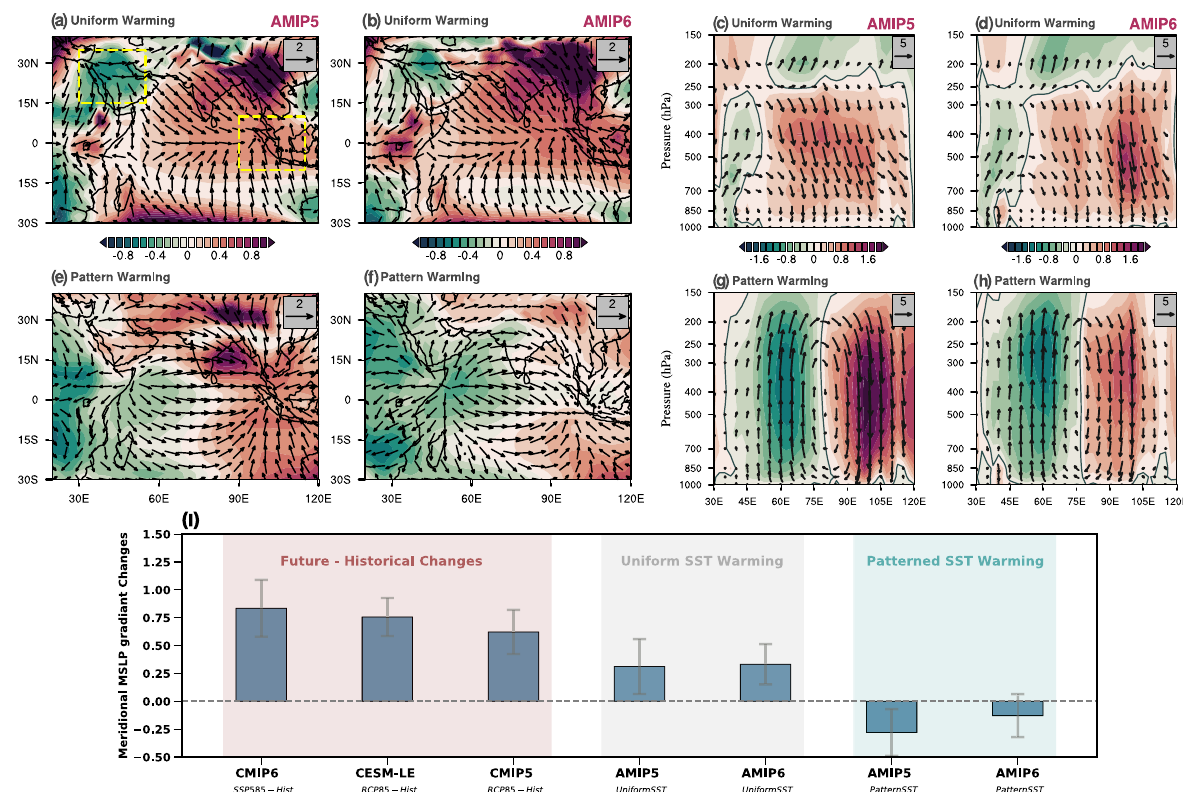
Fig. 4 Circulation changes in the uniform and patterned SST warming atmospheric-only model experiment. Ensemble mean changes in MSLP (hPa, shaded) and the divergent wind at 200 hPa (m/s, vectors) in a AMIP5 uniform SST warming (AMIP4K minus AMIP) and b AMIP6 uniform SST warming (AMIPP4K minus AMIP) simulations forced by prescribed SST change. e , f Same as in ( a , b ) but for AMIP5 patterned SST warming (AMIPFuture minus AMIP4K) and AMIP6 patterned SST warming (AMIPFuture4K minus AMIPP4K). The yellow boxes in fi gure a i.e., (90°E – 115°E, 10°S – 10°N) and (30°E – 55°E, 15°N – 35°N) are used to calculate the meridional MSLP gradient which represents the manifestation of the LHC on the surface (see “ Methods “ for more details). The longitude-height cross-section of ensemble mean changes in vertical velocity (Pa/s, shaded) and zonal wind-vertical velocity (vectors) from 1000 – 150 hPa in ( c ) AMIP5 and ( d ) AMIP6 uniform warming. g , h Same as in ( c , d ) but for AMIP5 and AMIP6 patterned warming experiment. Vertical velocity is multiplied by a factor 700. i Bar plot represents the ensemble mean changes in MSLP gradient (hPa) in CESM-LE (40 members, RCP8.5 minus historical), CMIP6 (17 models, SSP585 minus historical), and CMIP5 (24 models, RCP8.5 minus historical) and their comparison with uniform and pattern SST warming in AMIP5 and AMIP6. The error bars represent the ensemble standard